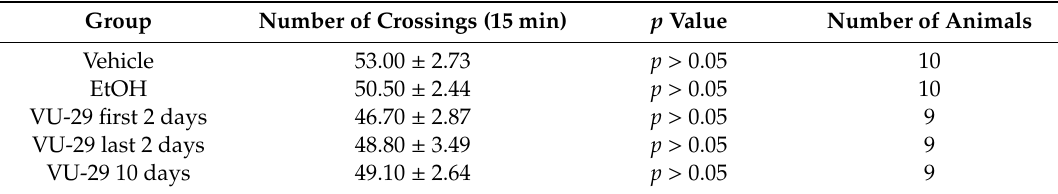
Table 2. The effect of VU-29 administration to ethanol-conditioned rats on locomotor activity measured as the number of crossings from one compartment to another during 15 min of Test 2. Results are expressed as mean ±